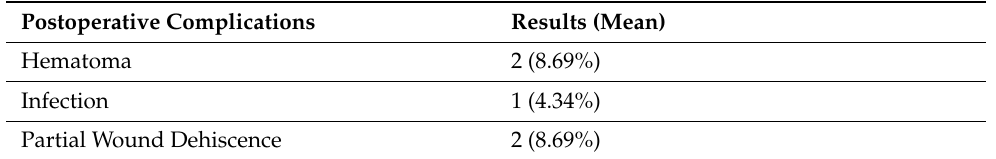
Table 2. Postoperative Complications